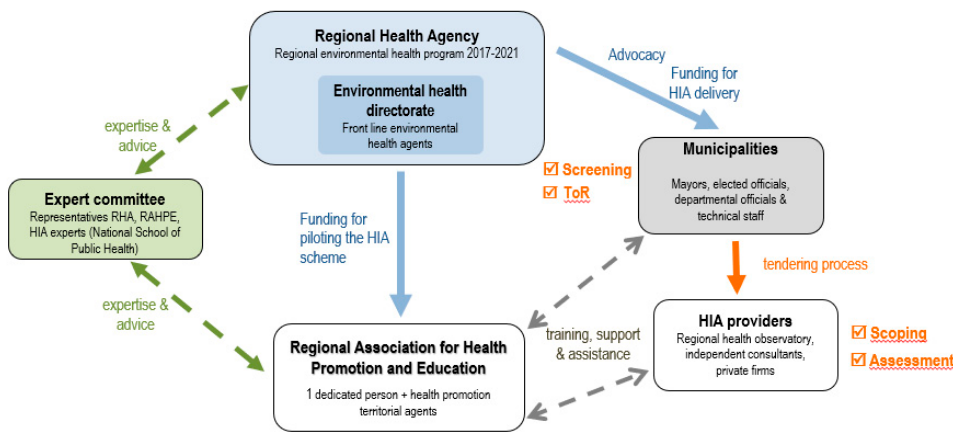
Figure 2. HIA implementation scheme in Nouvelle-Aquitaine.